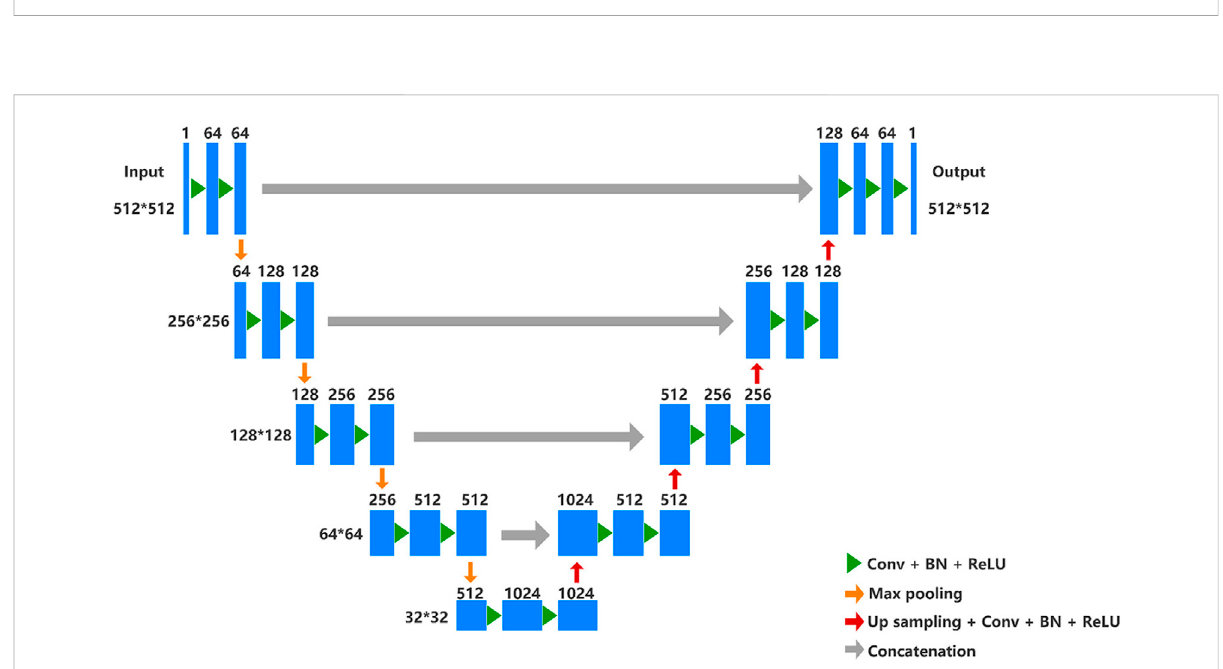
FIGURE 3 U-net architecture. Inthecontractingpath,every step consistsof downsamplingwith stridetwo ofthefeature mapanddoublesthenumber of featurechannels.Repeatedapplicationoftwo3×3convolutions(unpadded convolutions), eachfollowedbyarecti fi edlinearunit(ReLU)anda2×2 maxpoolingoperation.Intheexpansivepath,everystep consists ofan upsamplingofthefeaturemapfollowed bya2×2upconvolutionthathalves the number of feature channels, a concatenation with the correspondingly cropped feature map from the contracting path, and two 3 × 3 convolutions, each followed by a